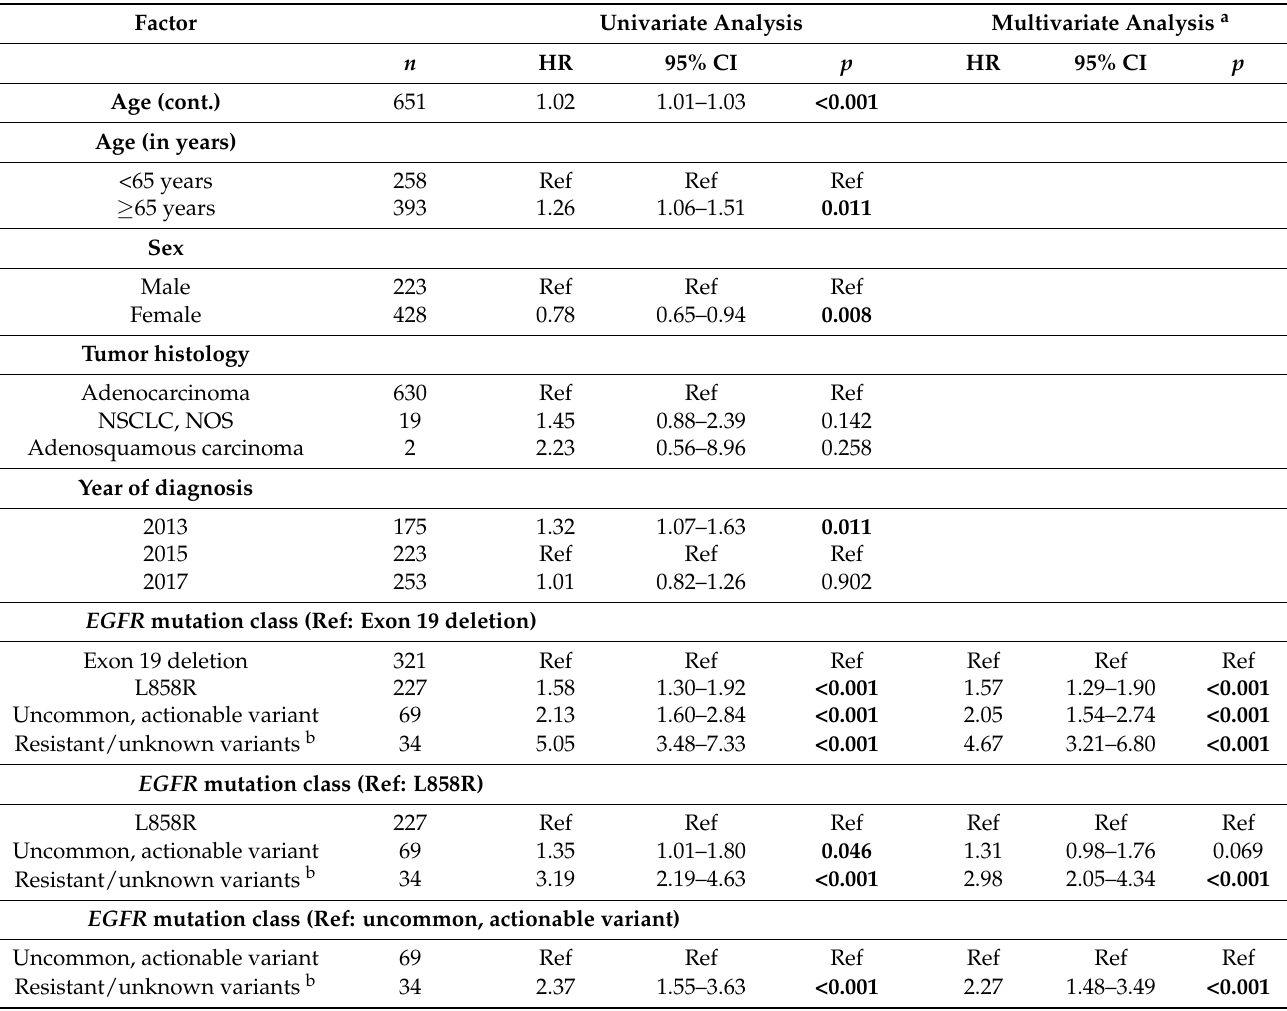
Table 3. Uni- and multivariate Cox regression overall survival analyses for EGFR mutation-positive NSCLC patients treated with first-line targeted therapy ( n =